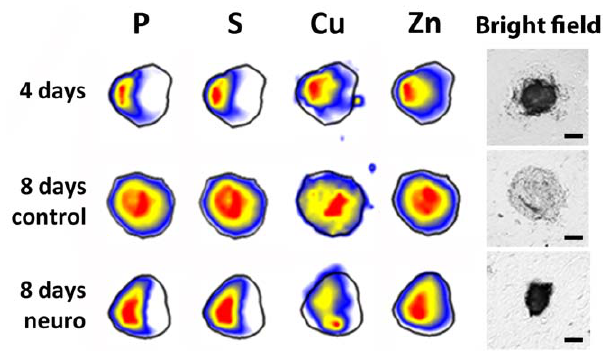
Figure 3. Atomic distribution within murine embryoid bodies. Top line: 4 days old murine embryoid body; Middle line: 8 days old control murine embryoid body; Bottom line: 8 days old neural induced murine embryoid body. Atomic elements are shown on the top line above the heat maps. All derived from the murine embryonic stem cell line R1. Maps are representative of all samples. Bright field images scale